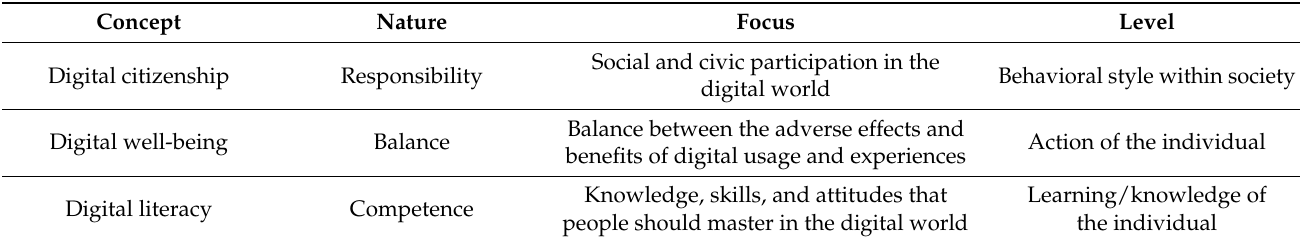
Table 1. Comparison of digital literacy, digital well-being, and digital citizenship. Concept Nature Focus Level Social and civic participation in the Digital citizenship Responsibility Behavioral style within society digital world Balance between the adverse effects and Digital well-being Balance Action of the individual benefits of digital usage and experiences Knowledge, skills, and attitudes that Learning/knowledge of Digital literacy Competence people should master in the digital world the